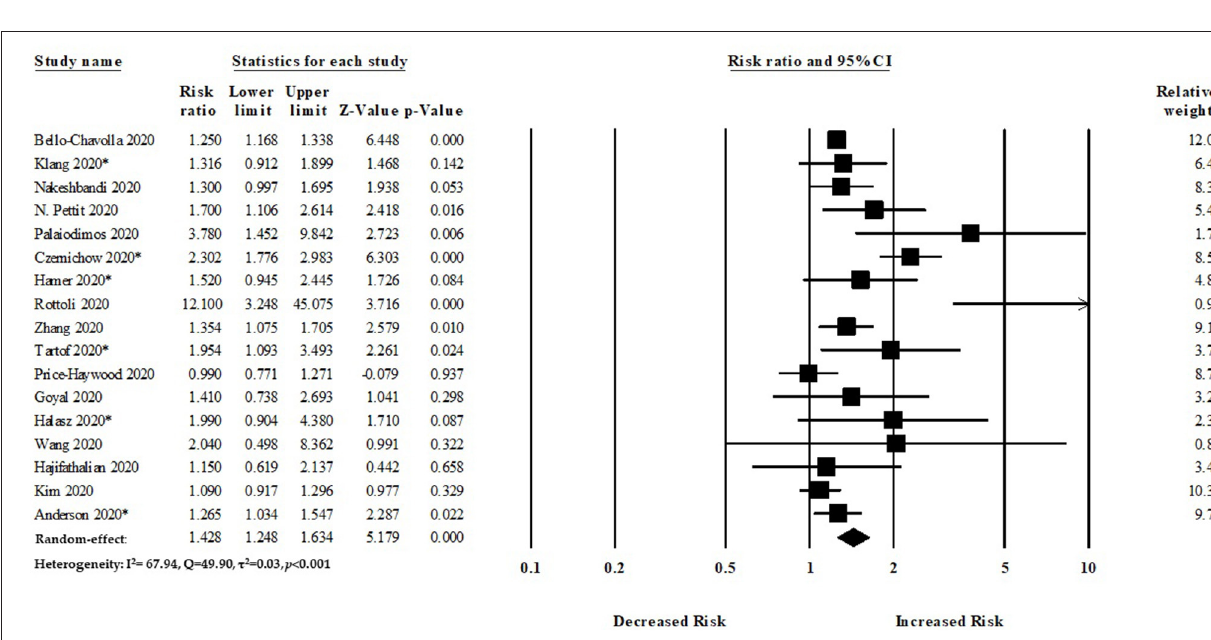
Frontiers in Medicine |